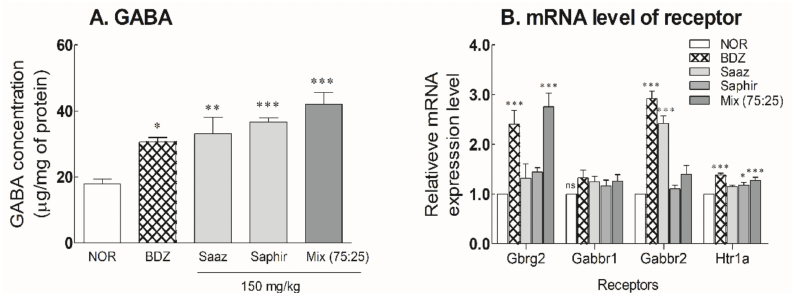
Figure 4. Effects of hops extracts on the content of ( A ) GABA and ( B ) mRNA expressions of GABAer- gic and serotonergic receptors in mice. NOR: the 0.9% NaCl (physiological saline) group (normal control), BDZ: Benzodiazepine treatment (positive control, 200 µ g/kg), Saaz (150 mg/kg), Saphir (150 mg/kg), and Saaz–Saphir (75:25, 150 mg/kg). Values are presented as the mean ± standard error of the mean (SEM) for each group, n = 6. Asterisks indicate significant differences: * p < 0.05, ** p < 0.01, and *** p < 0.001 vs. NOR by Tukey’s multiple comparison test. NOR: Normal, BDZ: Benzodiazepine, Gabrg2: GABA A receptor subunit gamma 2, Gabbr1: GABA B receptor subunit 1, Gabbr2: GABA B receptor subunit 2, and Htr1a: 5-hydroxytryptamine receptor